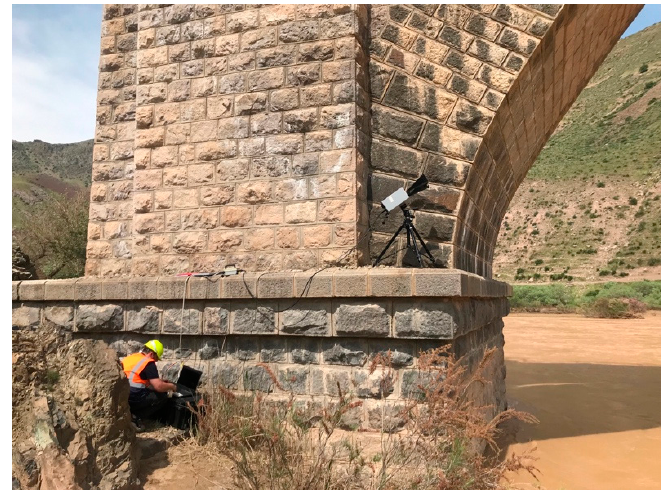
Figure 4. Radar installation at the Kaflan-Kuh Bridge.